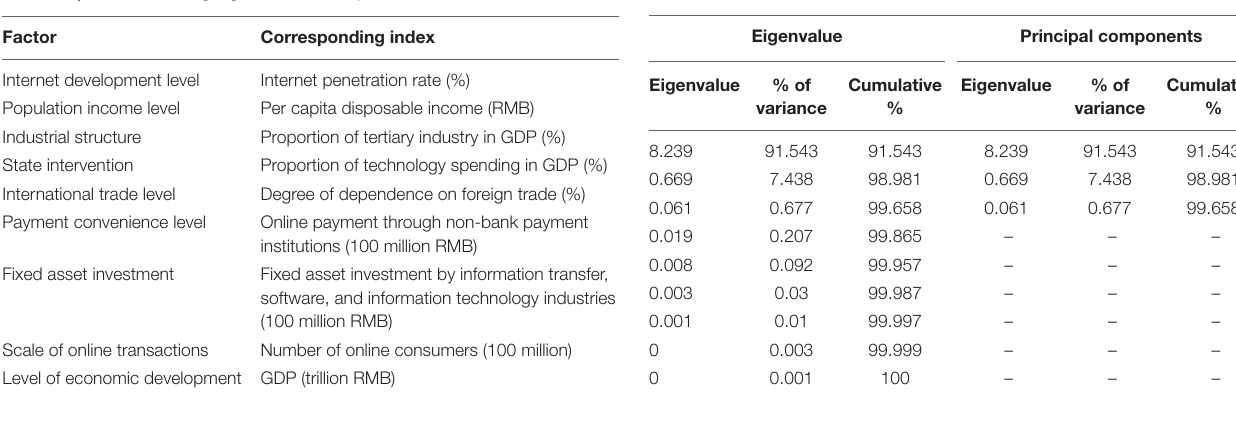
TABLE 8 | Variance